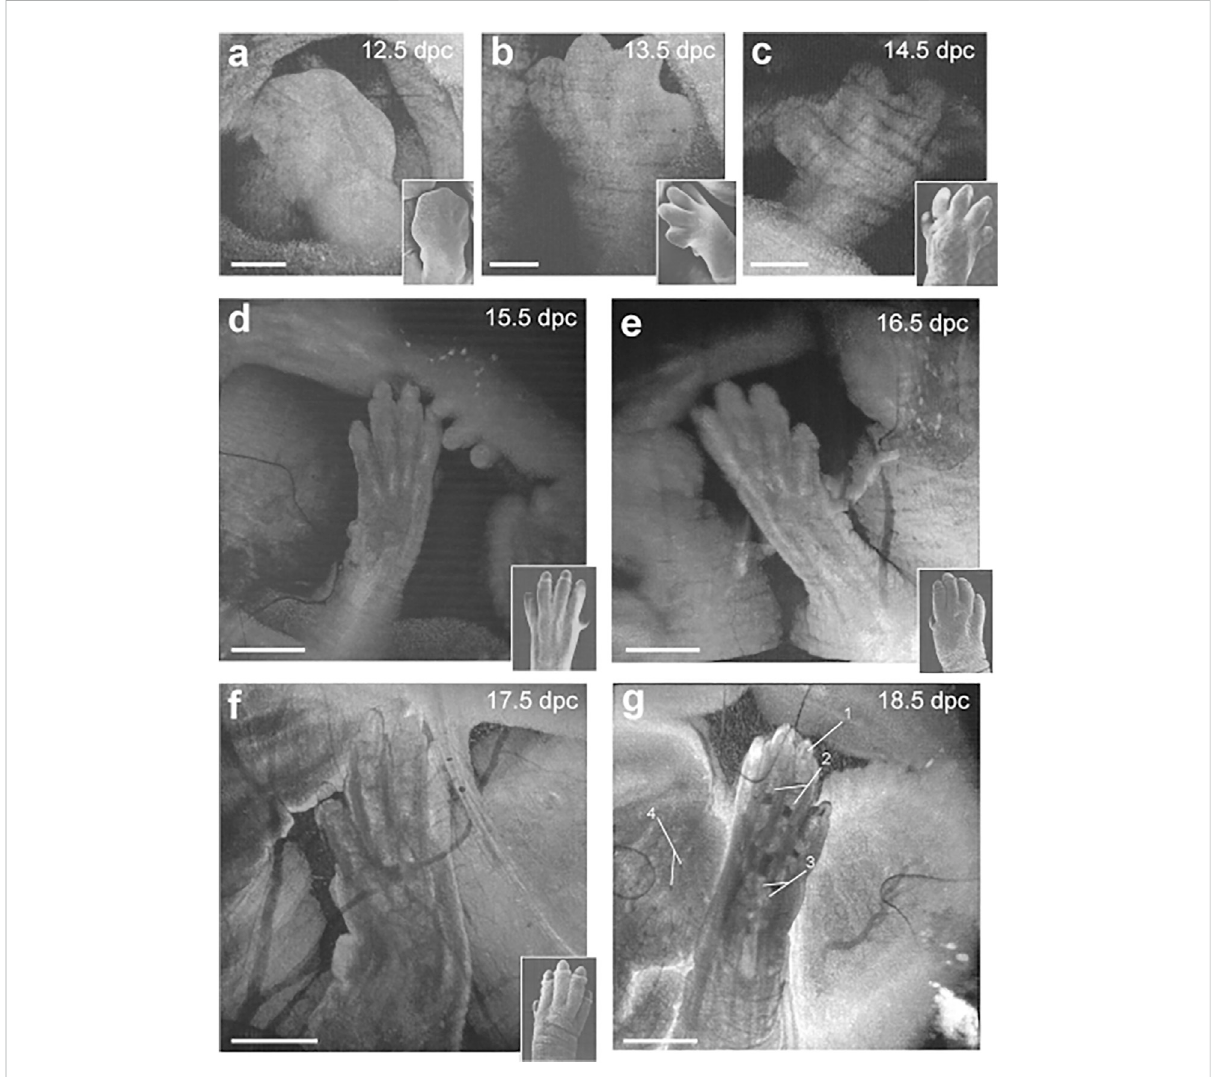
FIGURE 4 Live in utero phenotyping of mouse embryo limb development. (A – C) 3-D reconstructions of embryonic forelimb development at E12.5, E13.5 and E14.5 (scale bar: 500 µm). (D – G) 3-D reconstructions of digit formation at E15.5, E16.5, E17.5 and E18.5 (scale bar: 1 mm). Insets show scanning electron micrographs of the embryonic forelimb at the corresponding embryonic stages 1, cartilage primordium of distal phalanx; 2. Cartilage primordium of proximal phalanx; 3, cartilage primordium of metacarpal bones; 4, follicles of vibrissae. Reproduced from (Syed et al.,